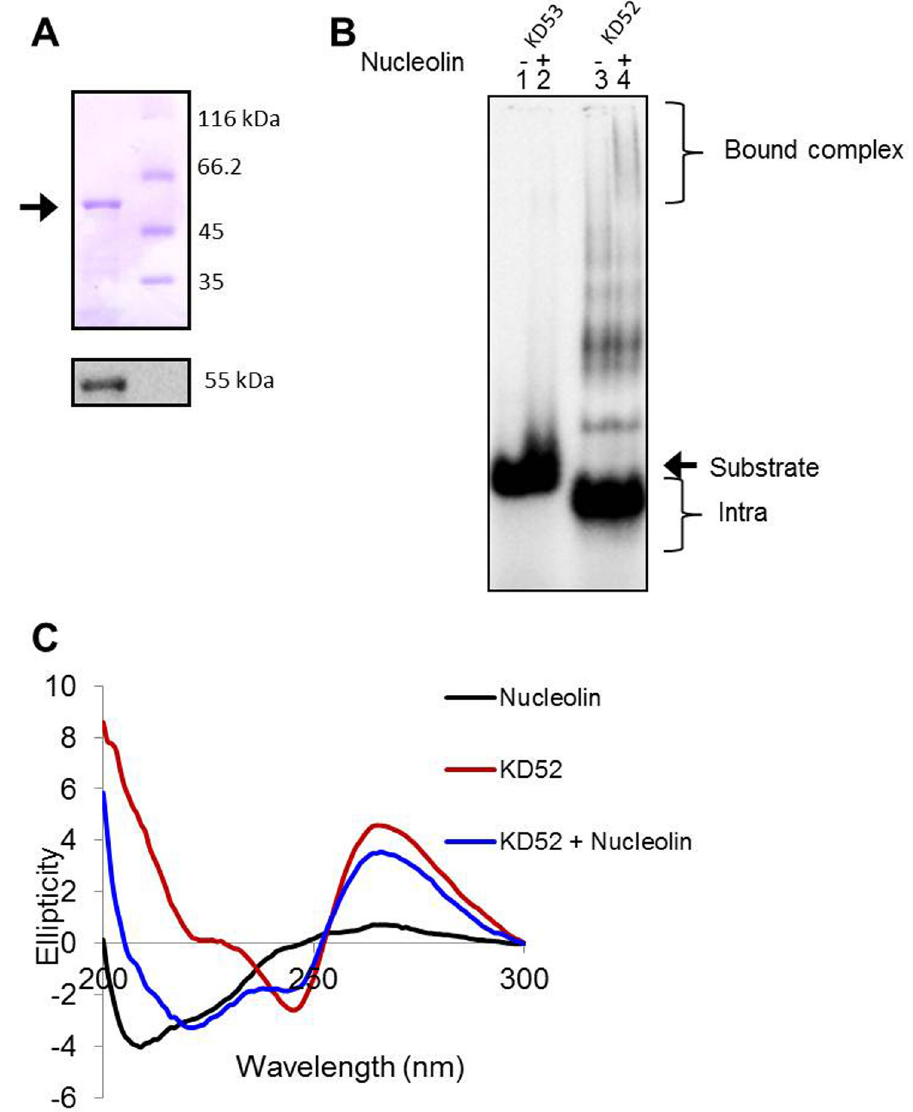
Fig 8. Binding of Nucleolin to G-quartets with GNGs as a structural component. (A) SDS PAGE profile showing purified recombinant His-tagged Nucleolin (55 kDa) (upper panel) and corresponding western blot using anti-His (lower panel). (B) Binding of purified recombinant Nucleolin to oligomers KD52 (harbouring two G stretches and GNG motifs) and its reverse complement KD53 in the presence of KCl (100 mM). (C) Analysis of CD spectra of recombinant His-tagged Nucleolin (20 μ g) and its ability to bind KD52.